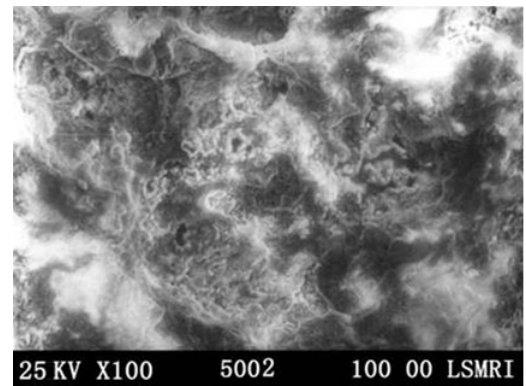
Figure 6 SEM micrographs of organic coatings after 5 months of the salt spray test.